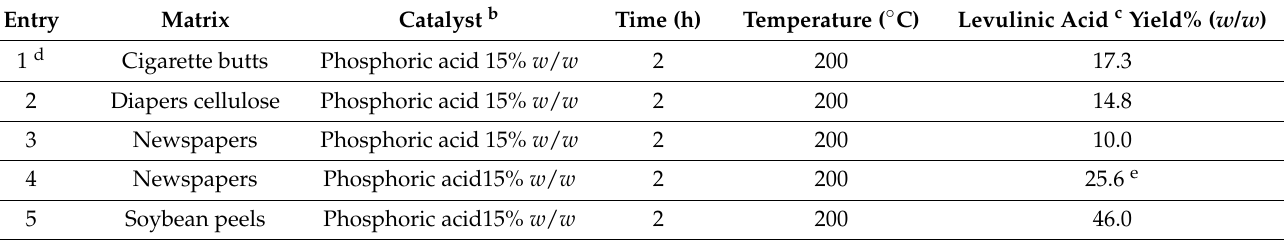
Table 3. Synthesis of levulinic acid from cellulosic waste a .